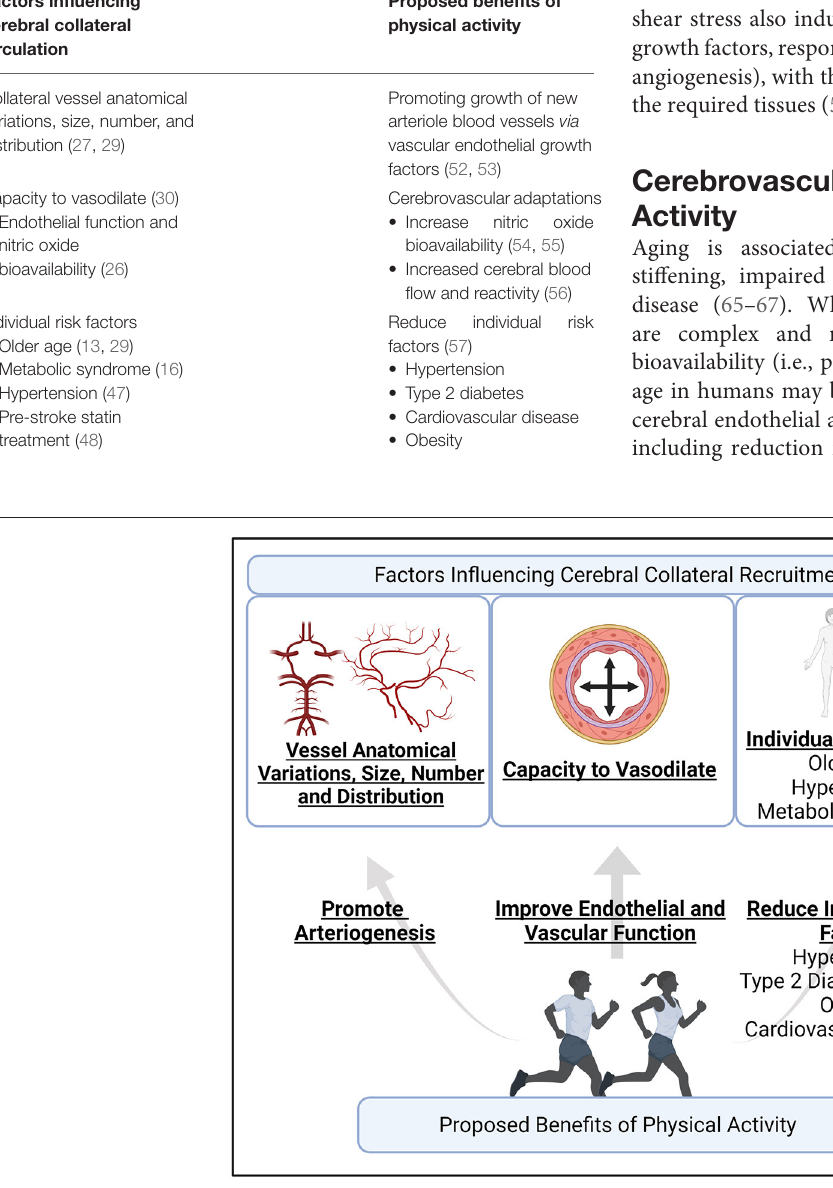
FIGURE 2 | An illustration of the proposed factors influence cerebral collateral recruitment, and how the benefits of physical activity may contribute to favorable collateral circulation recruitment. Cerebral collateral circulation recruitment depends on individual anatomical variations, number, size, and distribution of blood vessel, the capacity of blood vessels to vasodilate, and individual risk factors, such as age (13, 24). Physical activity can potentially contribute to arteriogenesis, including leptomeningeal arteries (52, 58), can improve cerebral endothelial and vascular function (56), and is well-documented in reducing the risk of hypertension, type 2 diabetes mellitus, obesity, and cardiovascular disease (59). Created with